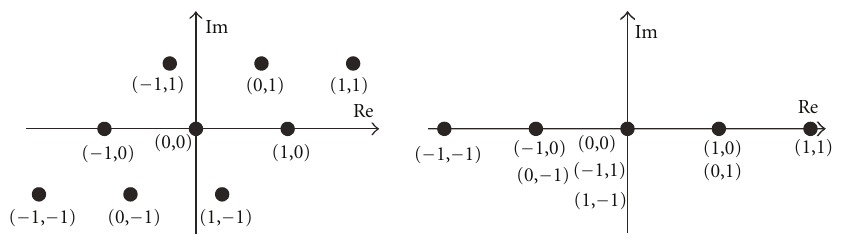
Figure 2: Constellation at the sink in a two-node example.